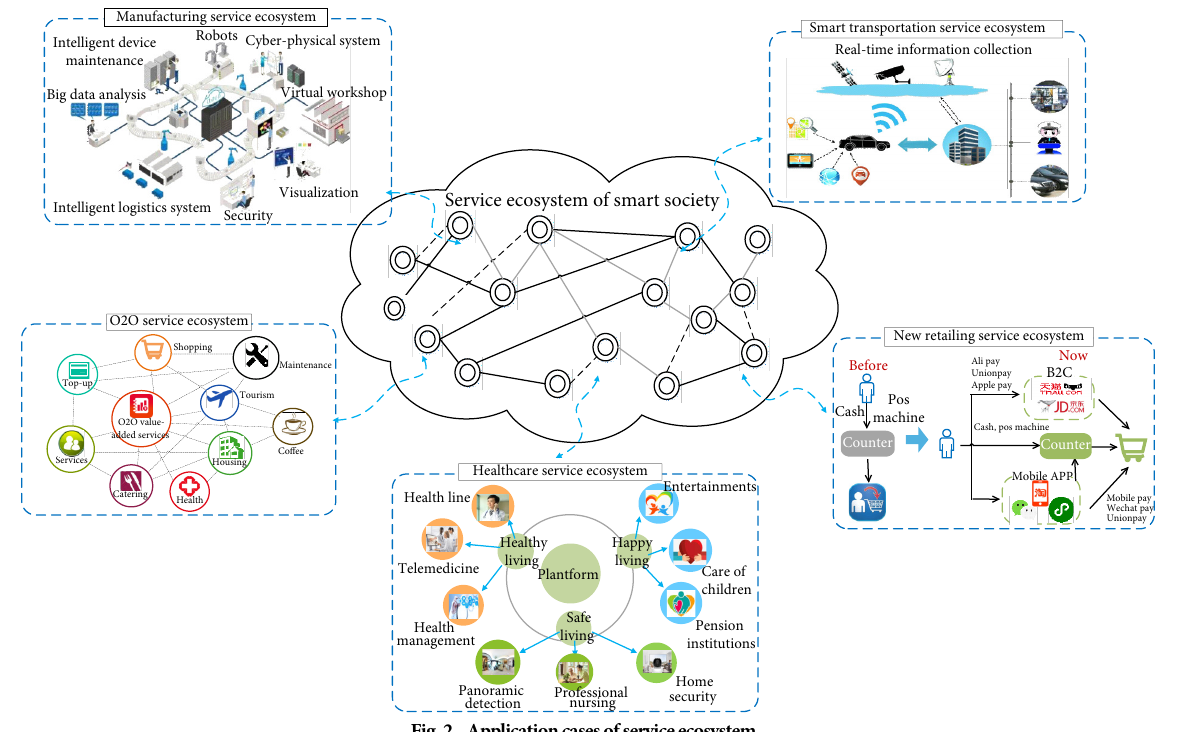
Fig. 2 Application cases of service